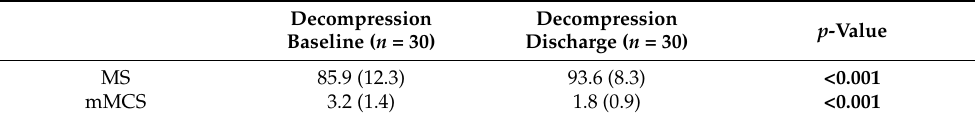
Table 4. Comparison of baseline (before surgery) and discharge neurological condition and functional status